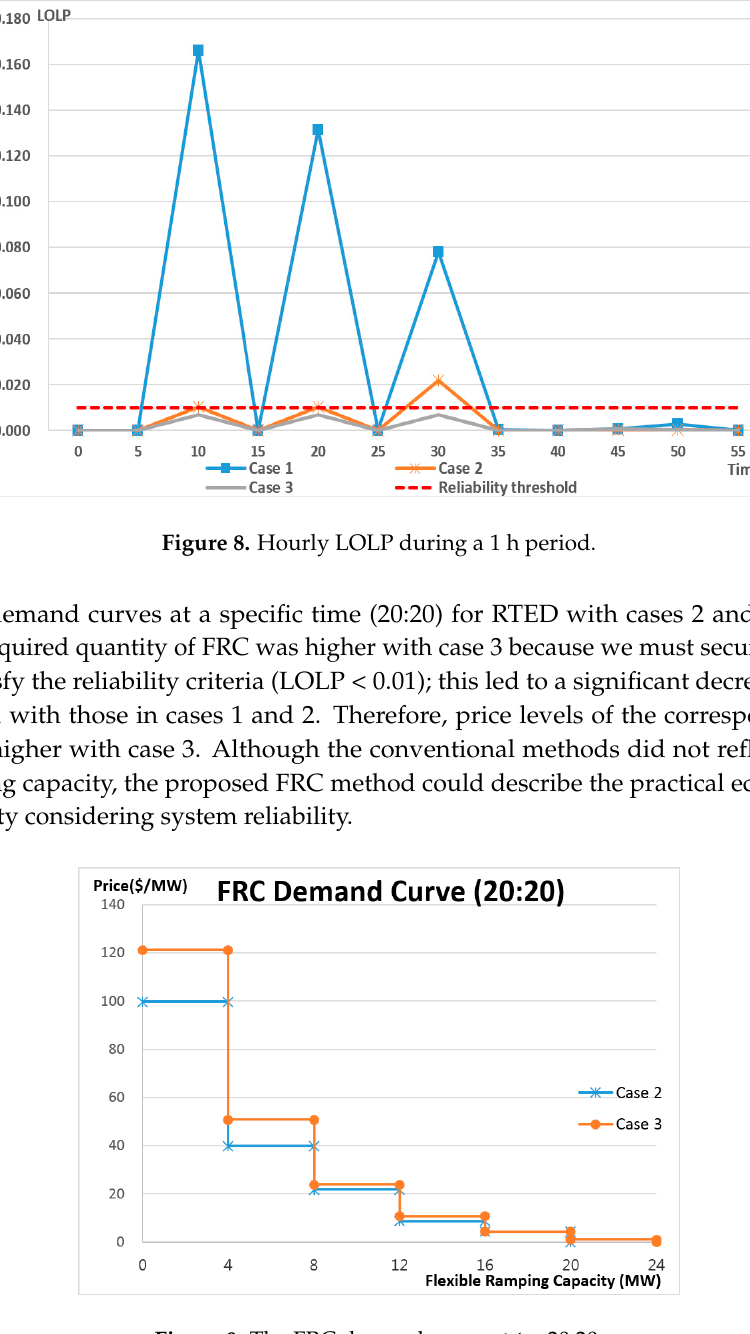
20 Table 8. The expected operating costs with RTED. Case